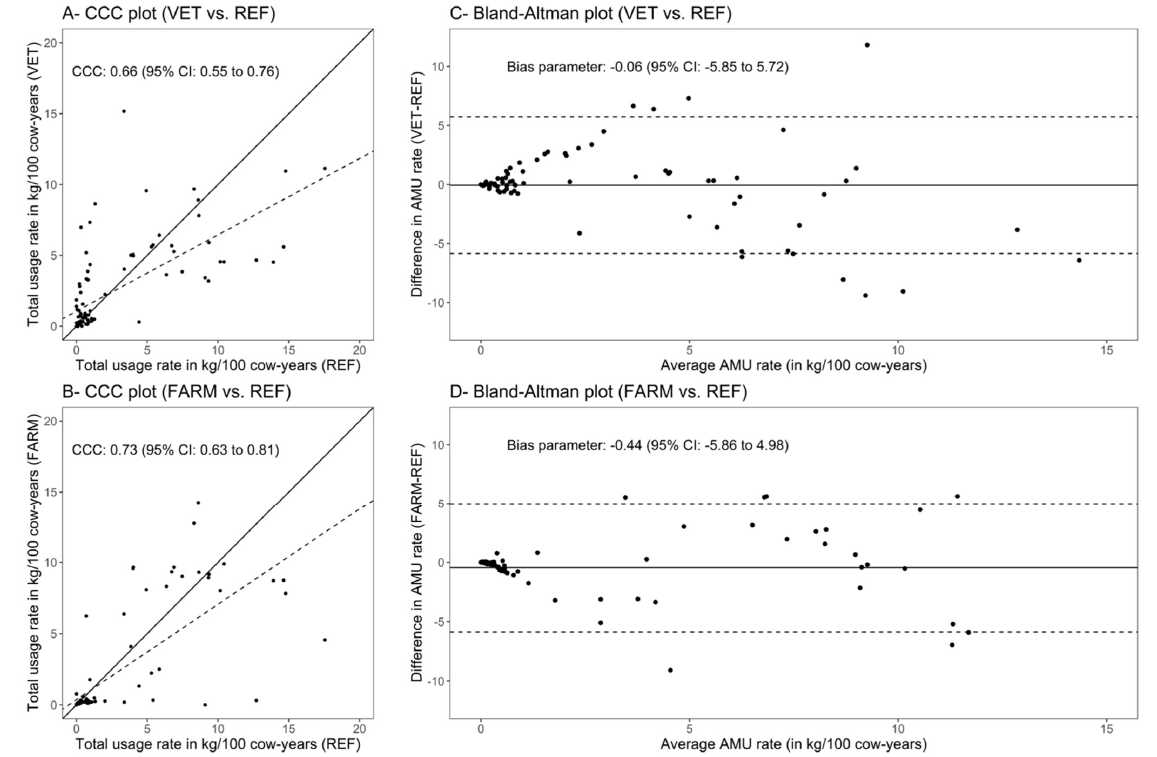
Figure 2. Concordance correlation coefficient (CCC) plots showing strength of association for quantification of total usage rate of antimicrobials (in kilograms /100 cow-years) between the reference method REF and methods VET (Plot A ) or FARM (Plot B ). The solid line represents the line of perfect concordance; the dashed line represents the reduced major axis. Bland–Altman plots showing agreement in quantification of total usage rate of antimicrobials (in kilograms/100 cow-years) between the reference method REF and methods VET (Plot C ) or FARM (Plot D ). The solid line represents the mean difference (estimated bias); dashed lines represent the 95% limits of agreement. Table 2. Concordance correlation coefficients (CCC) and their 95% confidence interval (95% CI), and mean differences and their 95% limits of agreement, to report agreement for quantification of usage rate of antimicrobials in feed (in kilograms/100 cow-years) between quantification using feed mill invoices (reference method REF) and quantification using veterinary prescriptions (VET method) or in-person interviews of dairy producers (FARM method) by antimicrobial, category (medically important antimicrobials, MIA, or non-MIA), and totally from a sample of 101 dairy farms from Qu é bec,